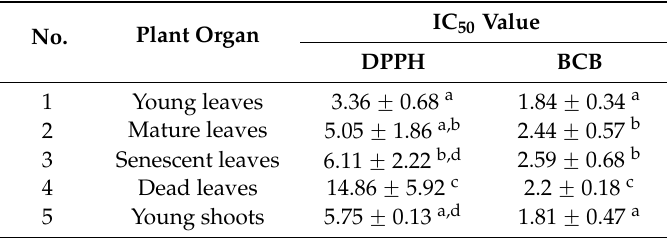
Table 3. IC 50 value for the DPPH radical-scavenging ability and β -carotene bleaching inhibition about the essential oils of the six plant organs from B. balsamifera.